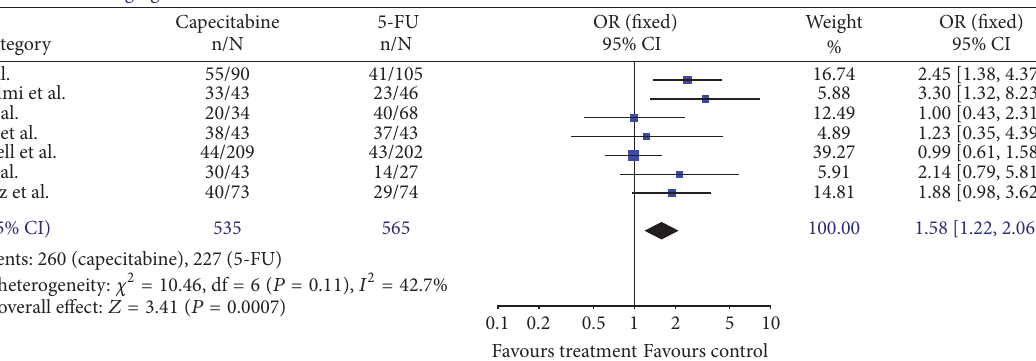
Figure 7). 16.2% (68/419) patients in capecitabine group